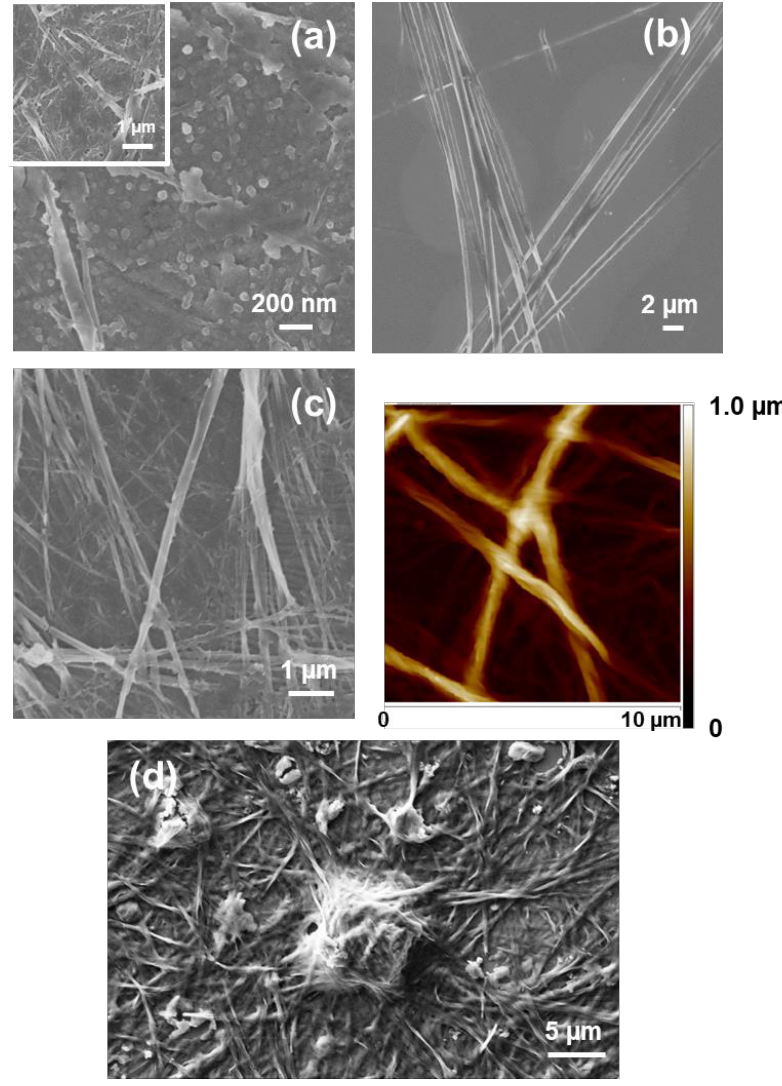
Figure 3. ( a – d ) SEM and ( c , right) AFM images of the structures obtained from FFFF solutions in ( a ) 1:99 HFIP:water (0.05 mg/mL), ( b ) 1:9 (0.5 mg/mL), ( c ) 1:4 (1 mg/mL) HFIP:water, and ( d ) 1:4 (1 mg/mL) HFIP:EtOH mixtures.